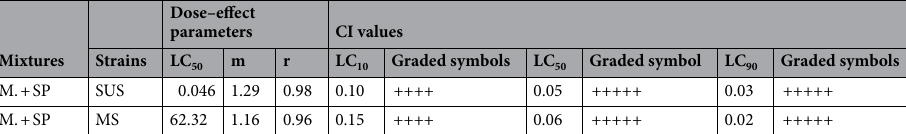
Table 4. Dose–effect relationship parameters and mean combination index (CI) values of the methoxyfenozide (M.)/spinetoram (Sp.) mixtures on laboratory (Susceptible) and resistant strains of S. littoralis. The parameter m is the slope of the median-effect plot (which signifies the shape of dose–effect curve), and r is the linear correlation coefficient (which signifies the conformity of data to the mass-action law. LC 50 and m are used for calculating CI values, CI < 1, CI = 1, and CI > 1 indicate synergism, additive effect, and antagonism, respectively.LC 10 LC 25 , and LC 50 are the concentrations required to reach a response mortality of 10, 25, and 50%, respectively. Graded symbols (++ + ++) very strong potentiation, (++ ++) strong potentiation, (+++) potentiation, (++) moderate potentiation, (+) slight potentiation 40,48 .